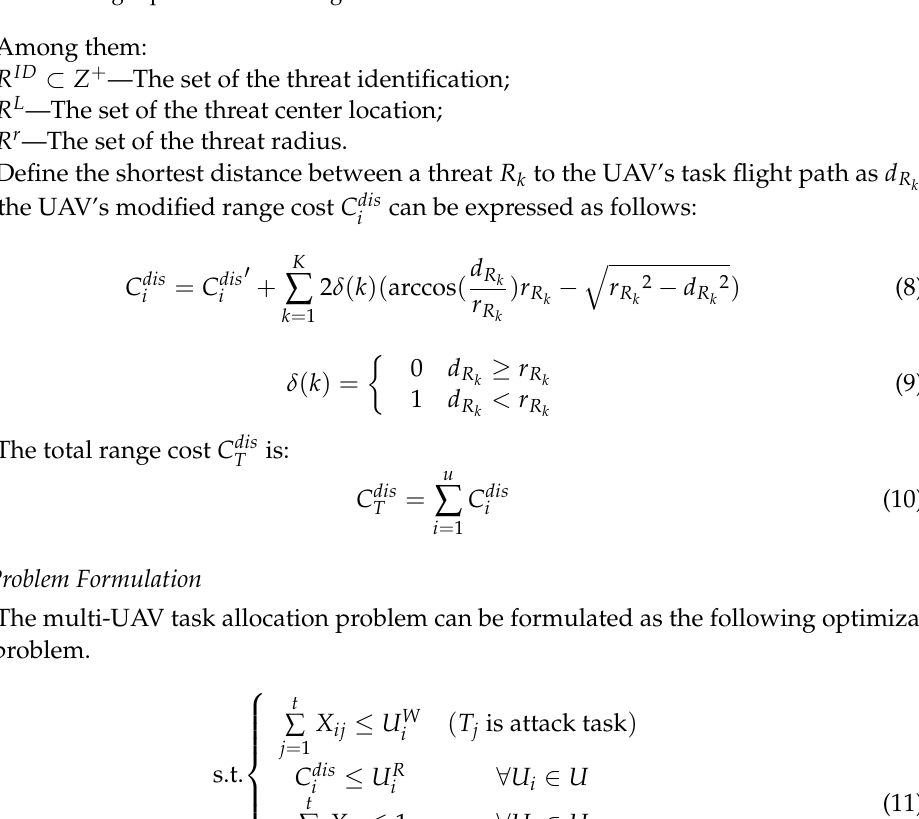
Figure 1. UAV flight path when meeting threat situation.